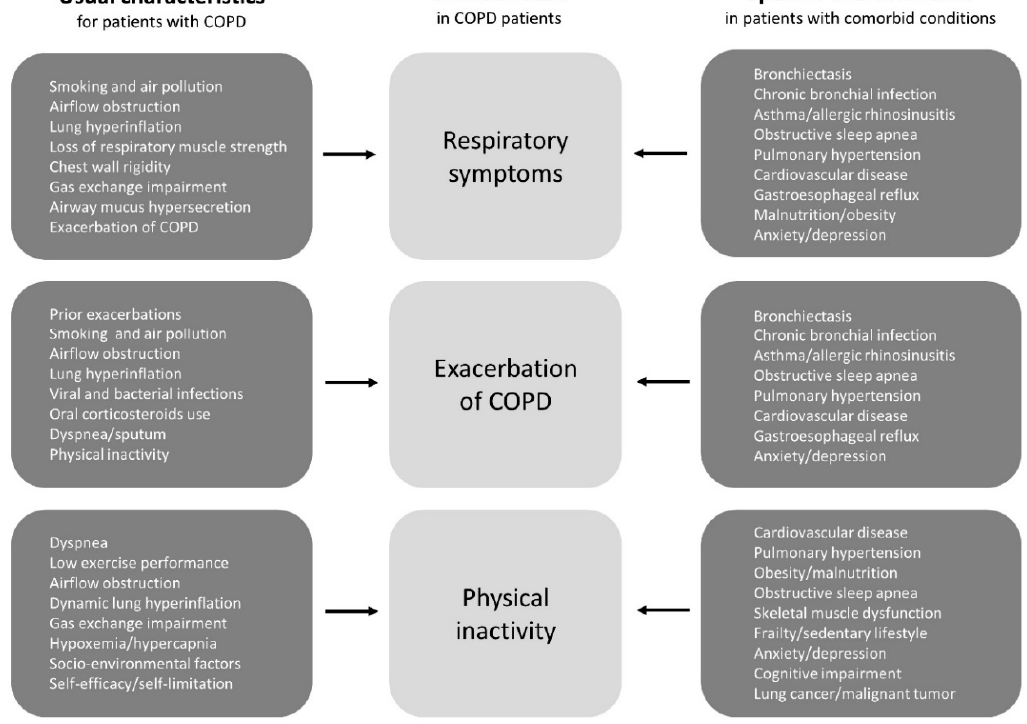
Figure 1. The risk factors and triggers for COPD patients’ unmet needs can be divided into two categories; one is the usual clinical characteristics of COPD patients and the other is the specific clinical characteristics of patients with comorbid conditions. Treatable conditions that are not recognized as therapeutic targets may be latent in patients with COPD. Abbreviations: COPD, chronic obstructive pulmonary disease.